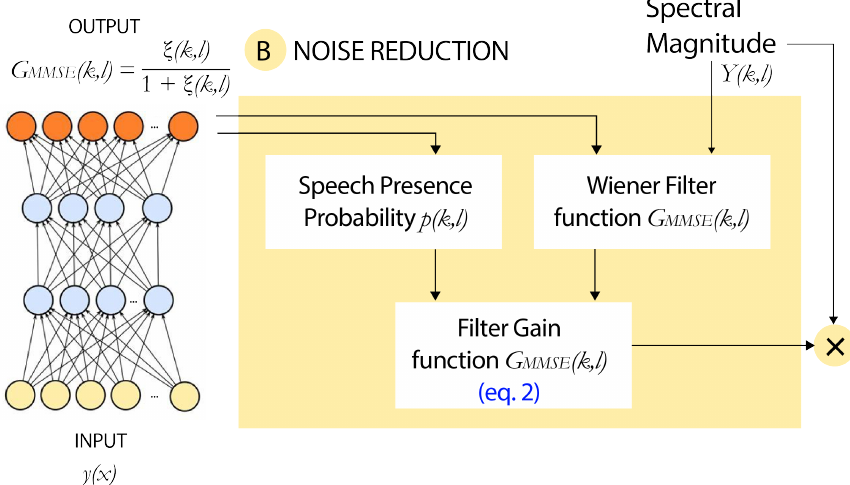
Figure 2. Noise reduction block based on Depp